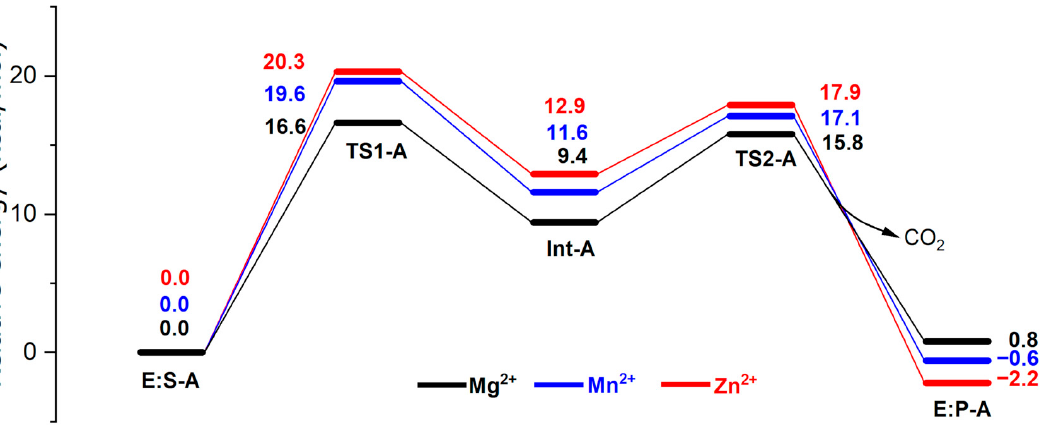
Figure 4. Calculated energy profiles for the decarboxylation reactions catalyzed by SDC with Mg 2+ , Mn 2+ , and Zn 2+ .